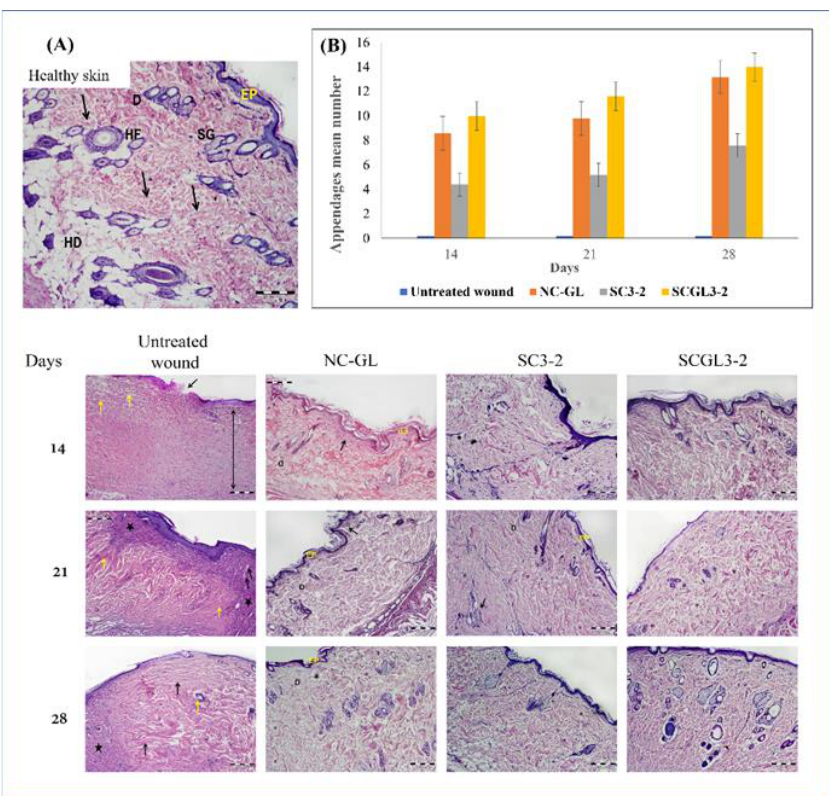
Figure 9. Histological evaluation of skin at days 14, 21 and 28 post-excision. ( A ) Histopathological micrographs of H&E-stained skin sections at days 14, 21 and 28 post-excision: The healthy thin skin shows a continuous epidermis (EP), loosely arranged collagen bundles (arrows) and plentiful hair follicles (HF). D: Dermis; SG: sebaceous glands; HD: hypodermis. The untreated wound control at the 14th day shows a discontinuous epithelium (black arrow), excessive dermal granulation tissue with cellular infiltration (double head arrow) and parallel collagen bundles (yellow arrows). At day 21, the wound exhibits an intense inflammatory infiltrate (asterisks), congested capillaries (black arrows) and hyalinized collagen bundles (yellow arrows). After 28 days, the dermis shows parallel hyalinized collagen bundles (black arrows), persistence of areas of granulation tissue (asterisk) and few dermal appendages (yellow arrow). The NC-GL-treated wounds show complete bridging of the epidermis (EP), a gradual increase in properly arranged collagen and a gradual subsidence of a mild inflammatory infiltrate (arrows). The wounds treated by SC3-2 show a continuous epidermis (EP), organized collagen bundles within the dermis (D) and focal areas of cellular infiltration (arrows). The wounds treated by SCGL3-2 show apparently normal histological features (H&E stain, Mic. Mag 100×). ( B ) Morphometric analysis of skin appendages. Statistical comparison between the stud- ied groups is conducted according to the mean number of skin appendages per microscopic field ( n = 5).